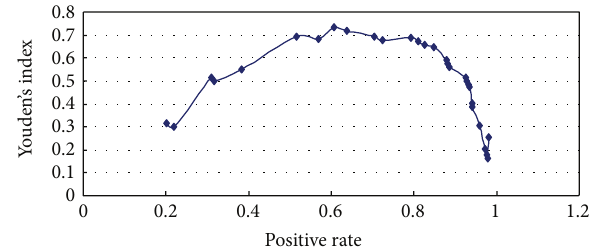
Figure 5: Youden’s index for coapplying rabeprazole test and SF-36 in diagnosing